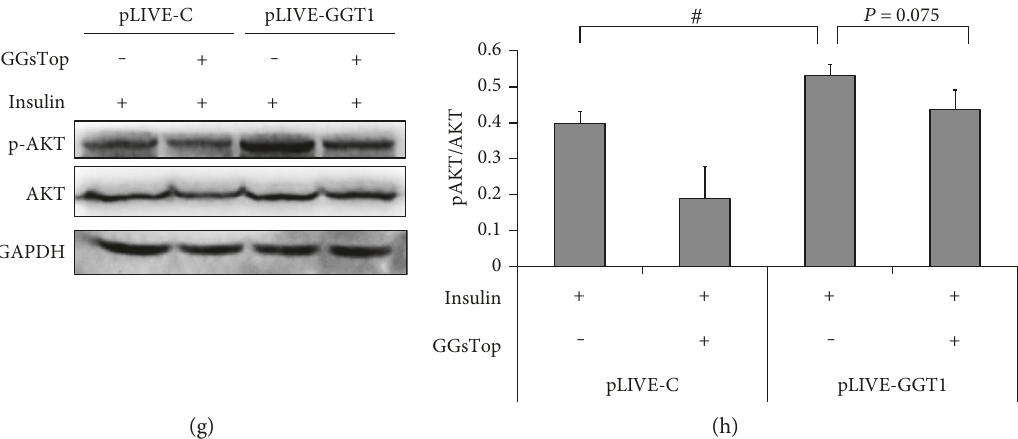
Figure 4: Overexpression of GGT1 in the liver increased insulin sensitivity. (a) ITT was performed and the blood glucose was measured at the indicated time points ( n = 13 – 17 ); (b) AUC of blood glucose after ITT. (c) The liver from fasted C57BL/6 mice injected with or without 0.75U insulin/kg body weight for 15 min was subjected to Western blotting using a rabbit anti-phosphor-AKT (Ser473) polyclonal antibody or rabbit anti-total AKT polyclonal antibody. (d) Fold changes of phosphor-AKT versus total AKT relative to the basal levels in GGT1-L-OE and control mice were quanti fi ed by densitometry. (e) ITT was performed in GGT1-L-OE mice and GGT1-L-OE-sTop mice which were treated with GGsTop, a highly selective GGT inhibitor, and the AUC was counted (f). (g) Liver homogenates were immunoblotted with anti-phosphor-AKT (Ser473) antibody or anti-AKT antibody. (h) The relative expression of phosphor-AKT was presented by setting the mean density of blots. ∗ P < 0 05 , ∗∗ P < 0 001 , # <